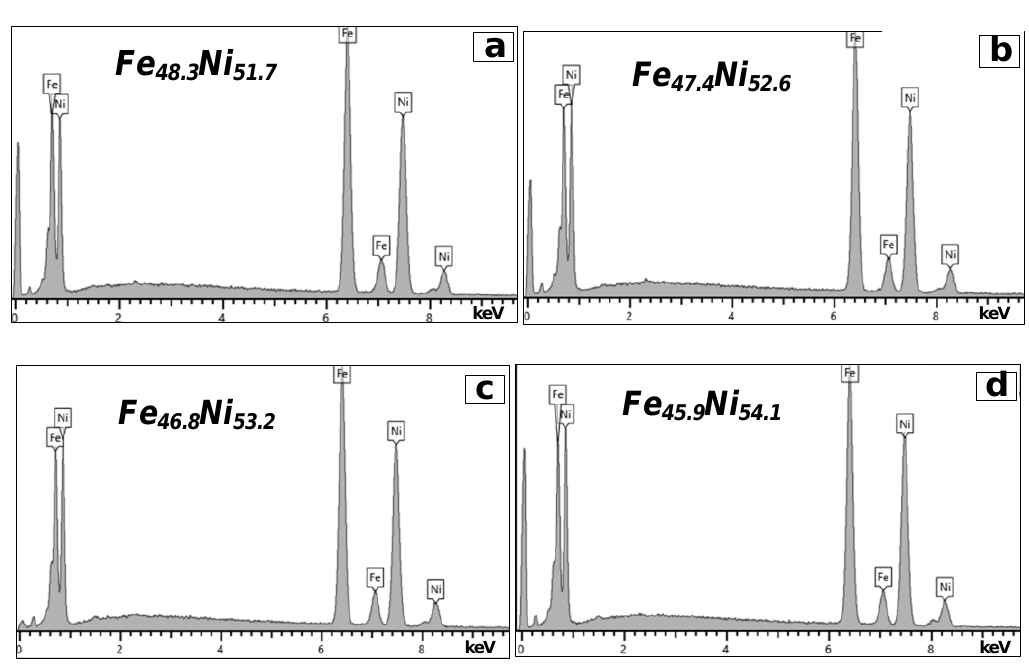
Figure 3. Nominal chemical composition of permalloy shielding coating: ( a ) P0, ( b ) P1, ( c ) P0.1, and ( d ) P0.01.